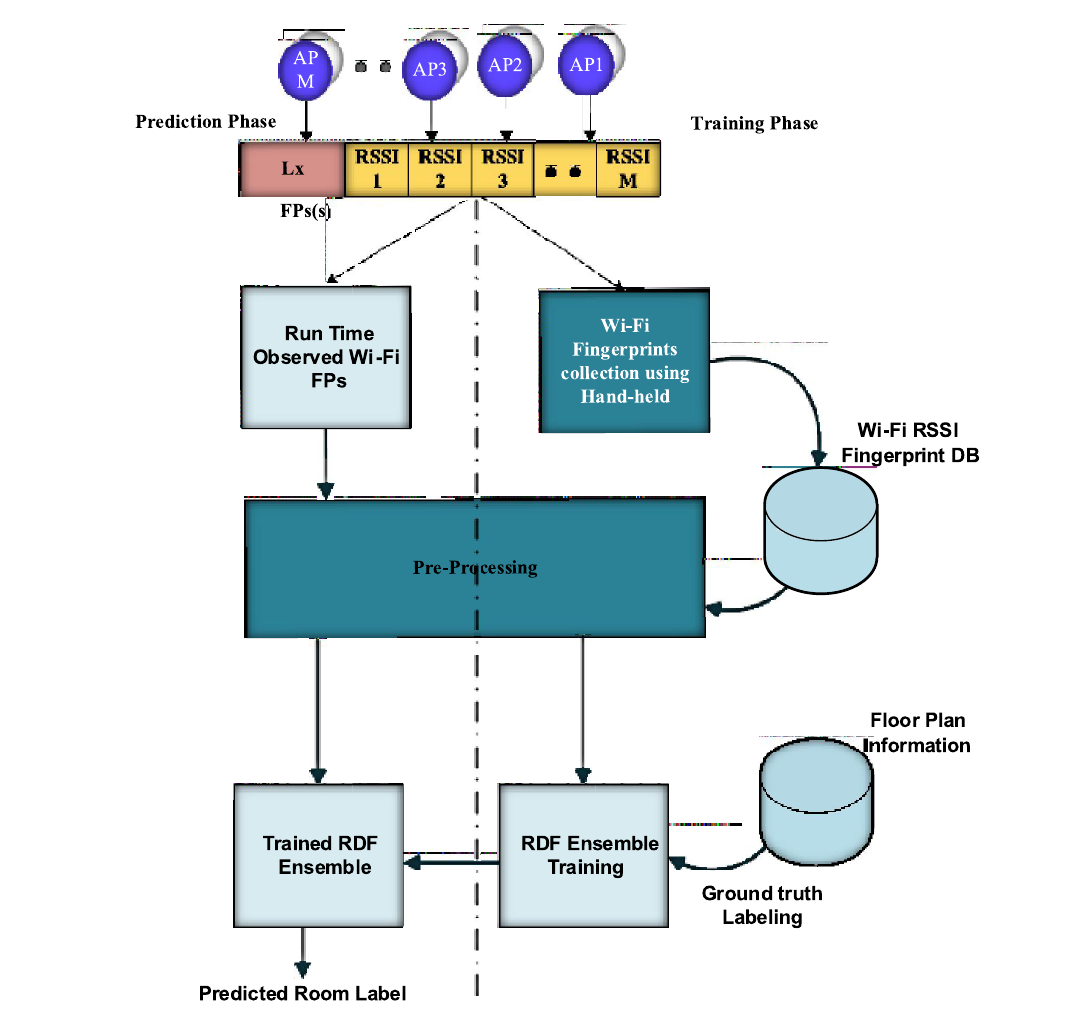
FIG. 2. PROPOSED LOCALIZATION FRAMEWORK TABLE 1. RDF CLASSIFICATION